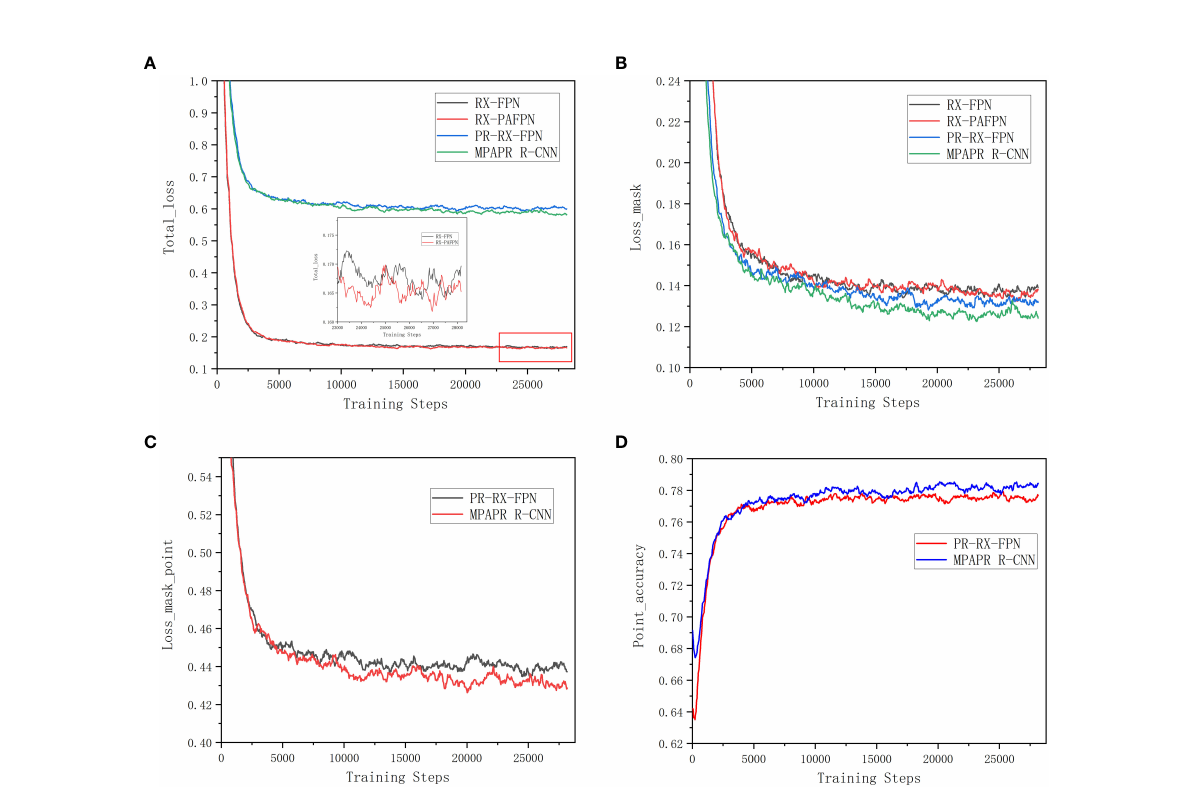
FIGURE 8 Loss and accuracy curves of several different instance segmentation algorithms in training stages. (A) Total loss curves. (B) Mask loss curves. (C) Mask point loss curves. (D) Point accuracy